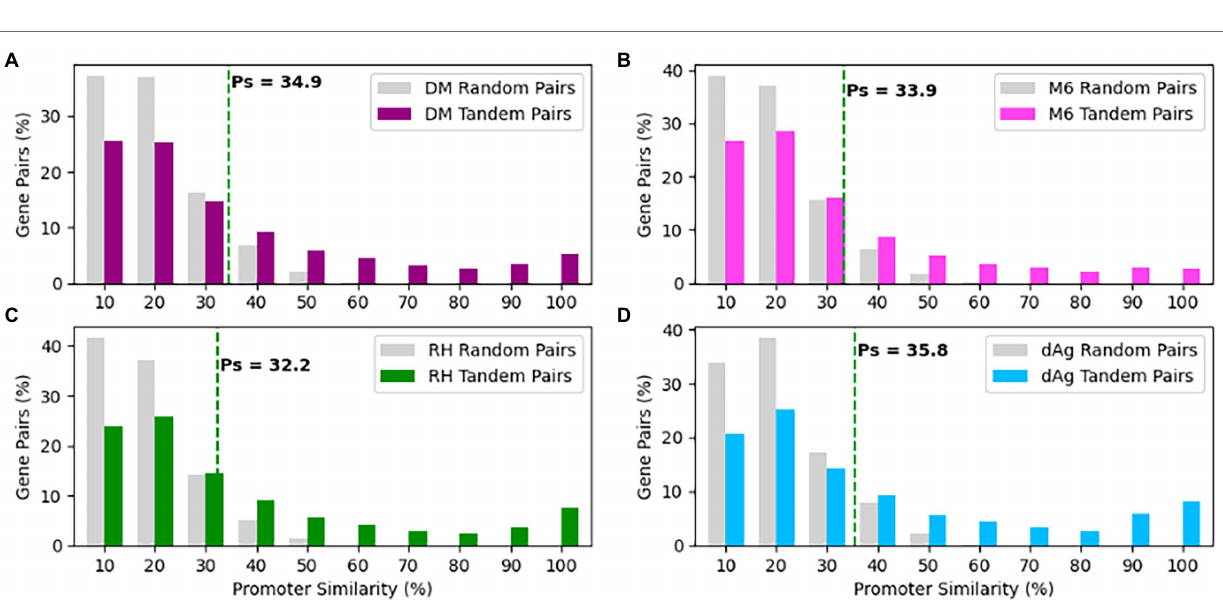
FIGURE 7 | Distributions of promoter similarities (Ps) between TDG pairs in (A) DM, (B) M6, (C) RH, and (D) dAg. The dashed green line indicates 95% quantile of Ps distribution of random gene pairs. Promoter pairs with Ps < 95% quantile indicates that the promoters of the gene pairs shown to diverged, while Ps ≥ 95% quantile indicates that the promoters of the gene pair shown to conserved in respective potato